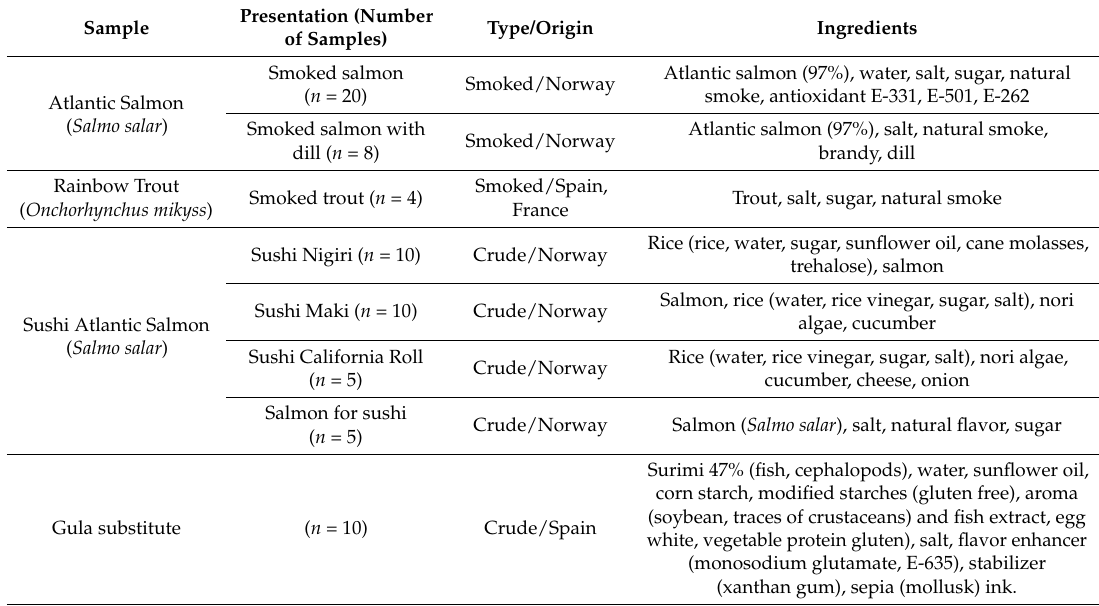
Table 3. Samples included in the